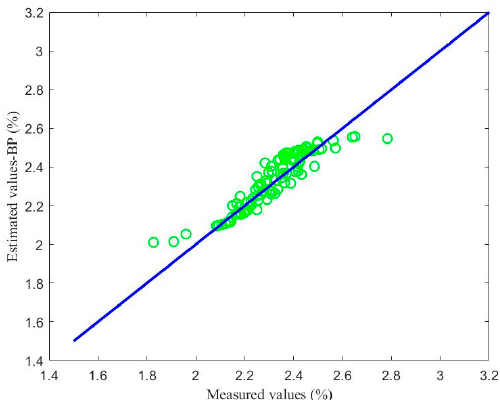
Figure 7. The estimated values of the soft sensor based on LSSVM compared with actual laboratory measurements.